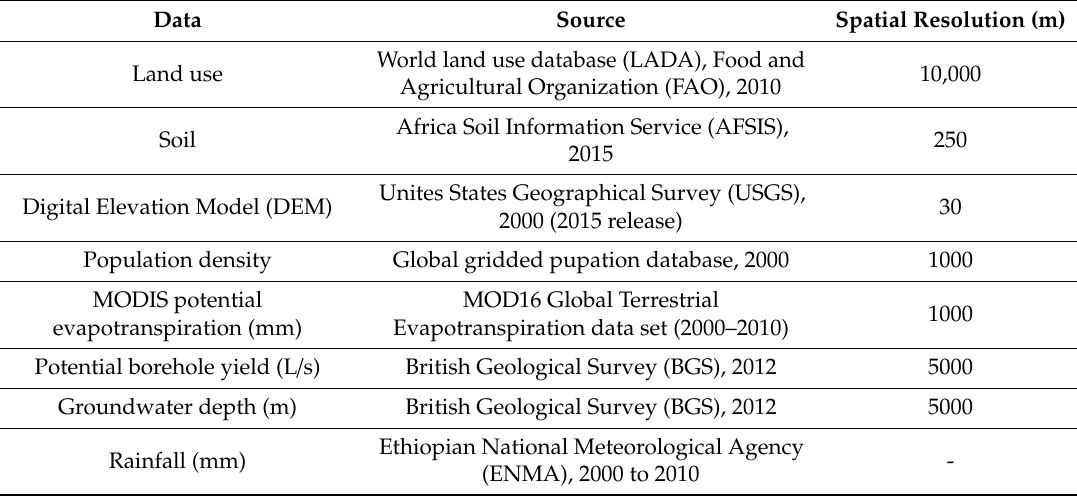
Table 1. Data and sources for upscaling crop production to the county